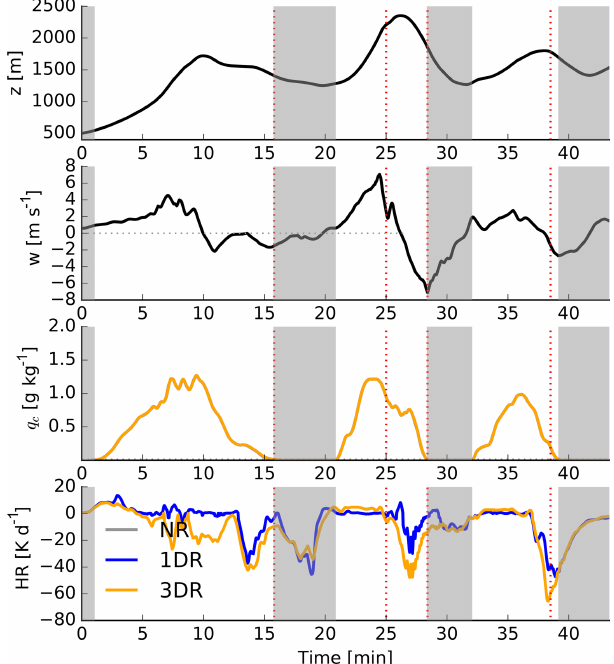
Figure 8. Similar to Fig. 5 but for the second selected